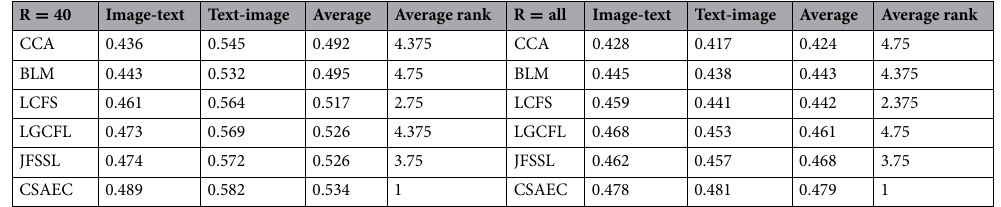
Table 1. MAP results of different methods